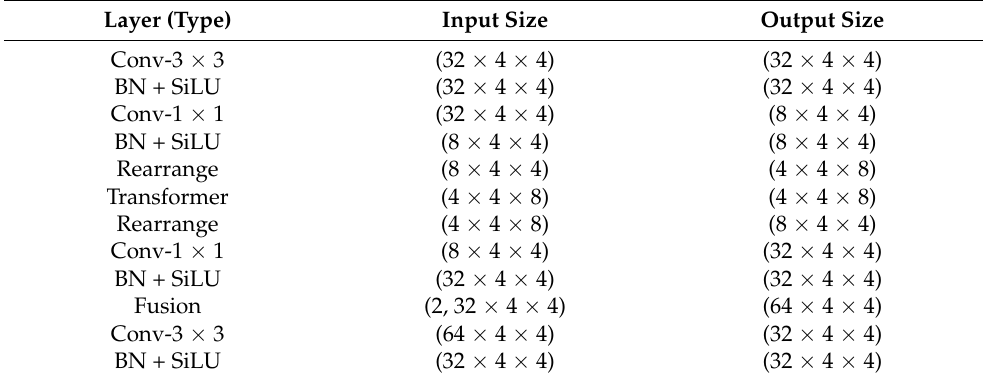
Table 4. Parameter settings of the MobileViT block when applied to the Pavia University dataset.